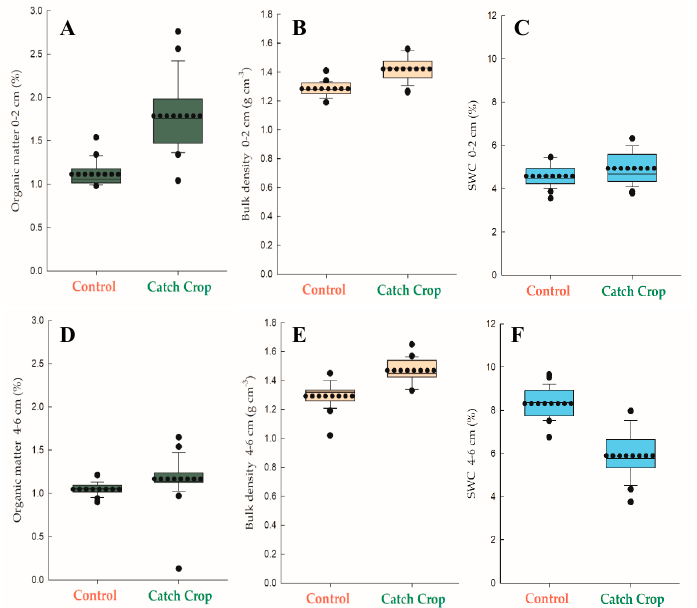
Figure 4. Soil properties at 0-2 and 4-6 cm of soil depth in the control and catch crop plots. SWC: Soil water content. Continuous line: median values; dotted line: mean values; circles: outliers; 5 th and 95 th percentiles are also represented per box plot. ( A ) soil organic matter (0-2 cm); ( B ) soil bulk density (0-2 cm); ( C ) soil water content (0-2 cm). And ( D ) soil organic matter (4-6 cm); ( E ) soil bulk density (4-6 cm); ( F ) soil water content (4-6 cm).